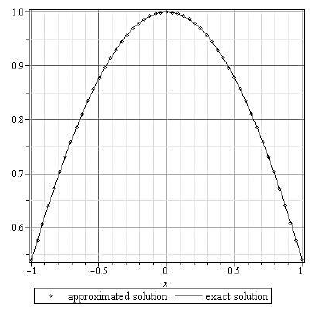
Figure 3. Exact and approximated solutions of Example 5 ( k = 7).